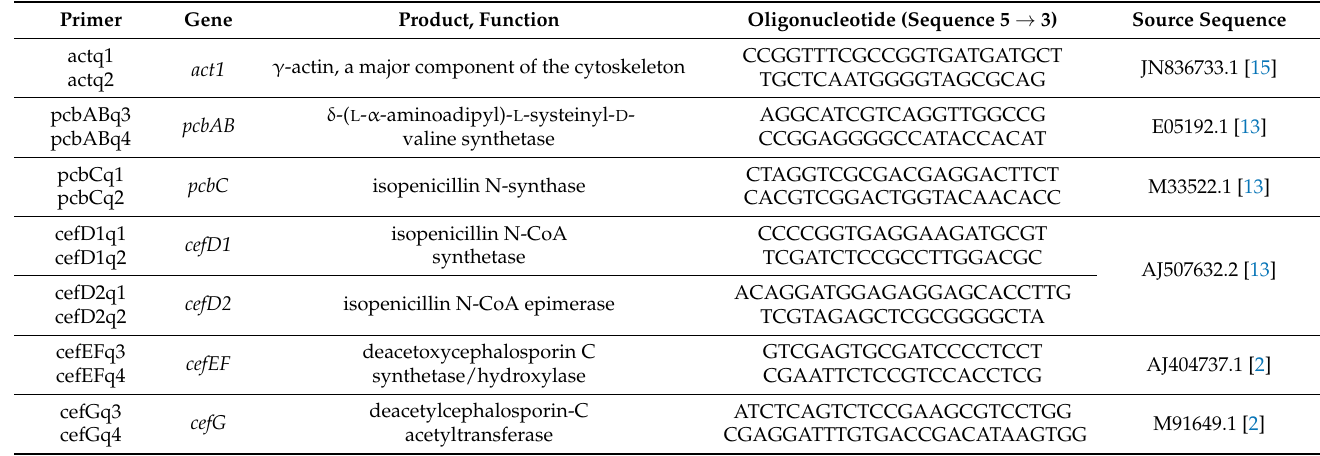
Table 1. Primers used for RT-PCR